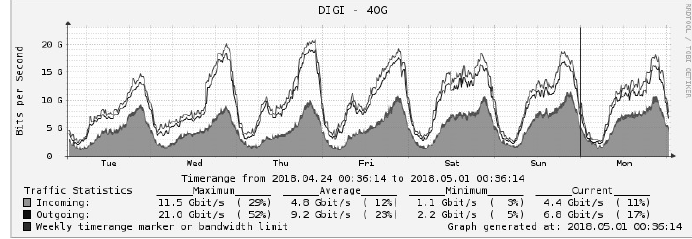
Figure 16. Data traffic of a Service Provider in one